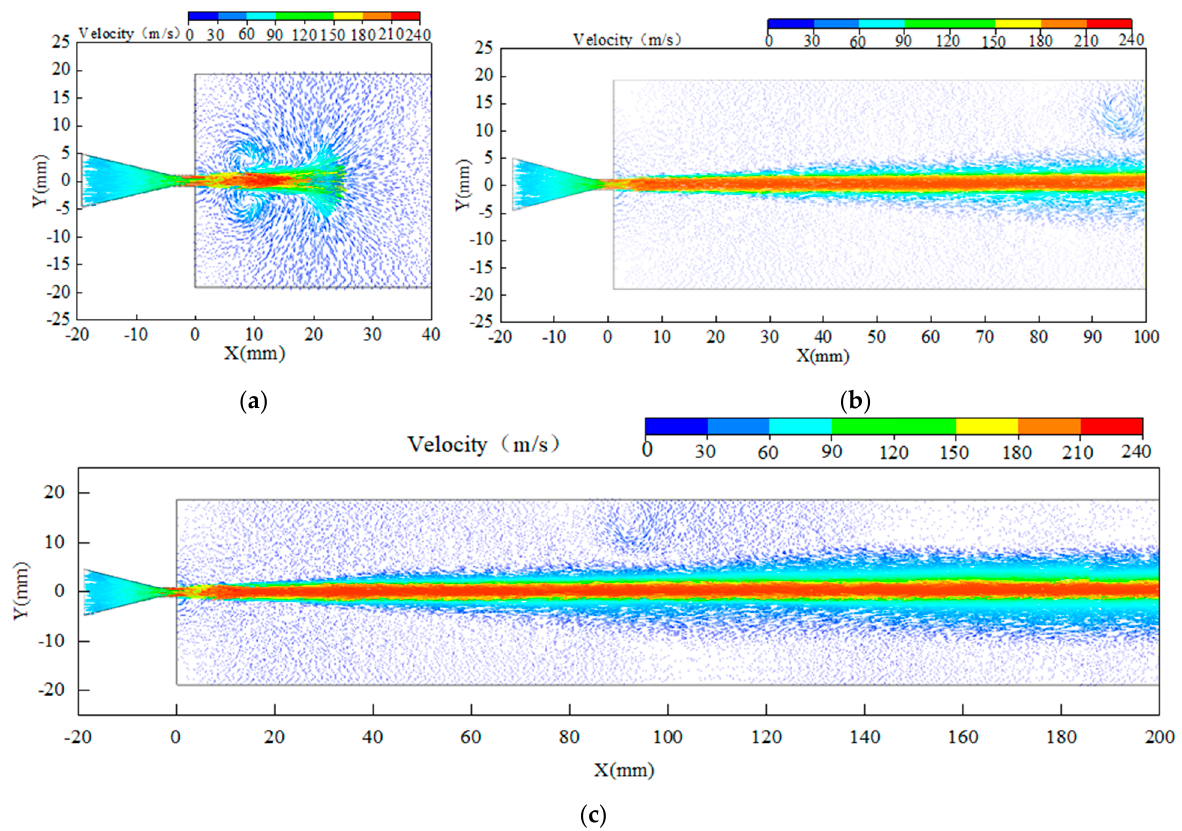
Figure 5. Velocity vector of the water jet at different times: ( a ) t = 0.02ms; ( b ) t = 0.8ms; ( c ) t =